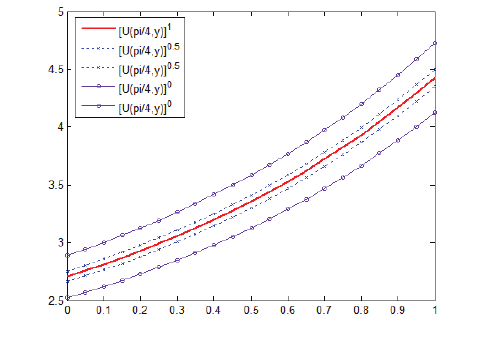
Fig. 7. The 2D graphs of some α − cuts of fuzzy solution.